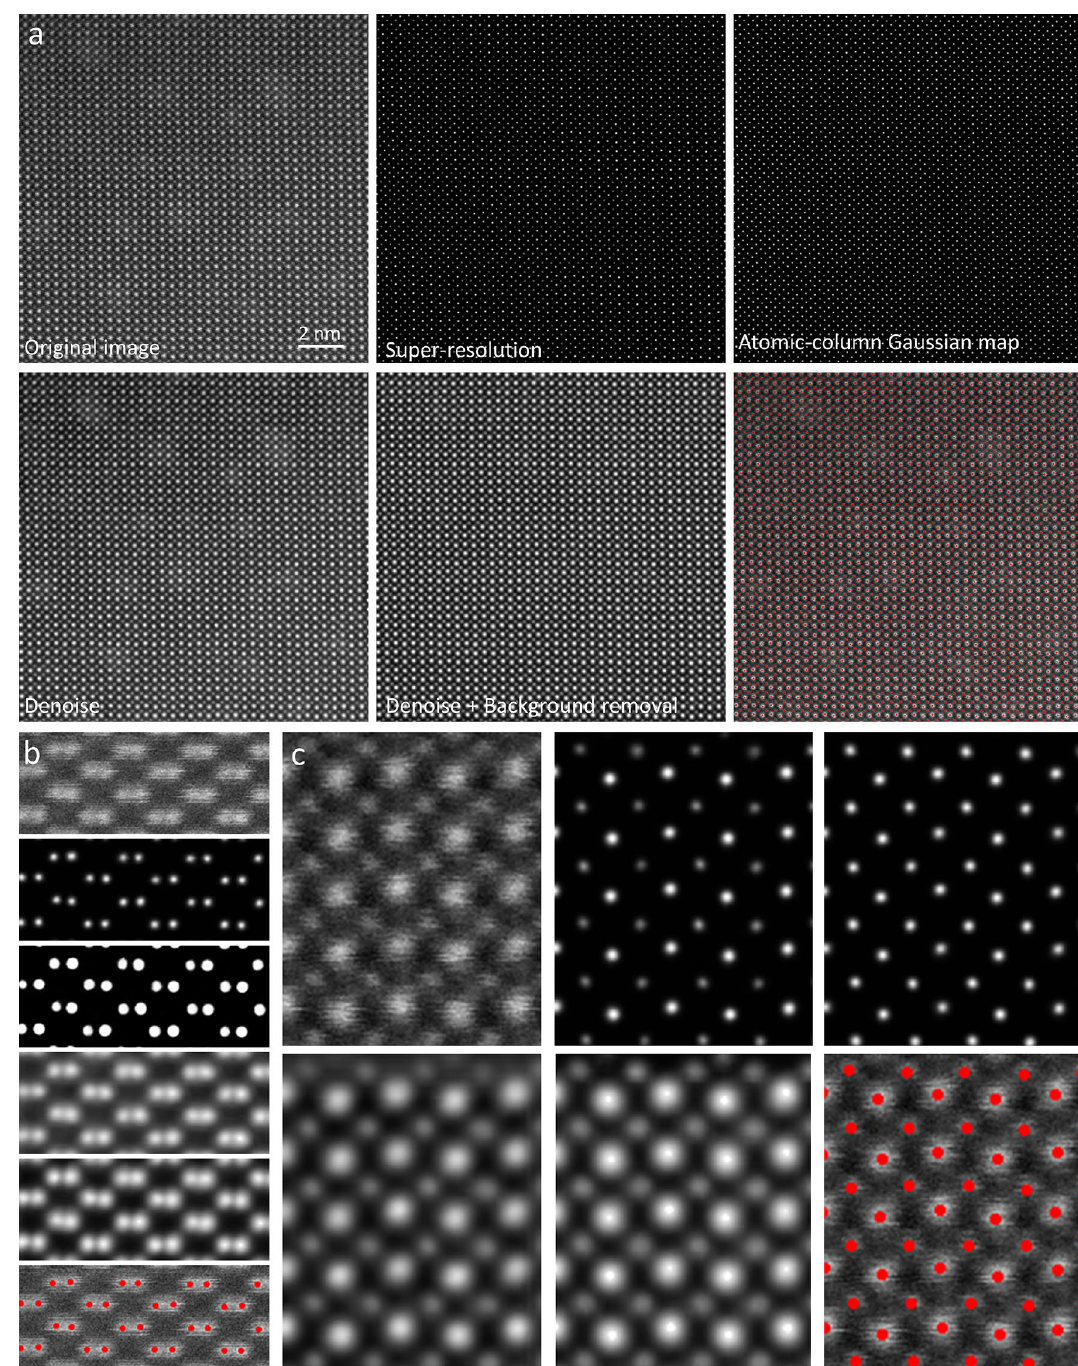
Figure 8. Experimental ADF-STEM images of and the AtomSegNet processing results. ( a , c ) cross-section specimen of